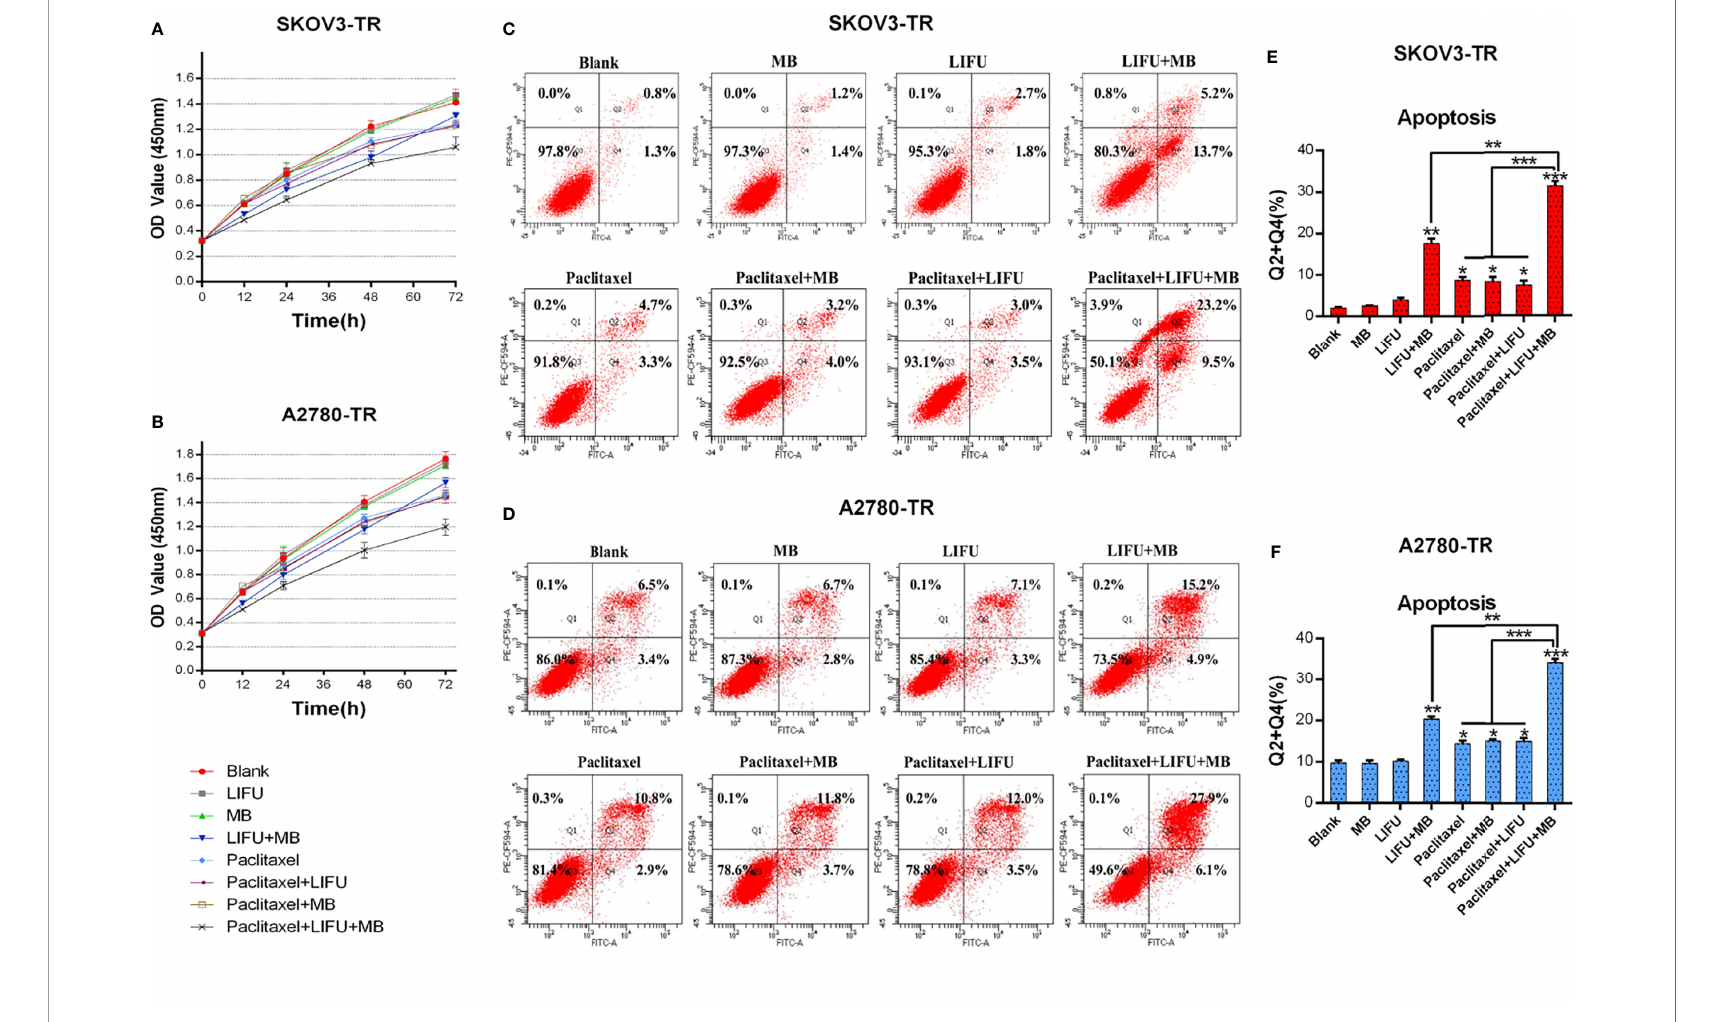
FIGURE 6 | LIFU+MB enhanced the chemosensitivity of SKOV3-TR and A2780-TR cells to paclitaxel. (A, B) OD values were assessed by the CCK-8 method in response to different treatment for different times. (C – F) Analysis of apoptosis rates by fl ow cytometry and quanti fi ed after different treatment. (*p < 0.05, **p < 0.01, ***p < 0.001, n = 3, student t-test, means ± 95%